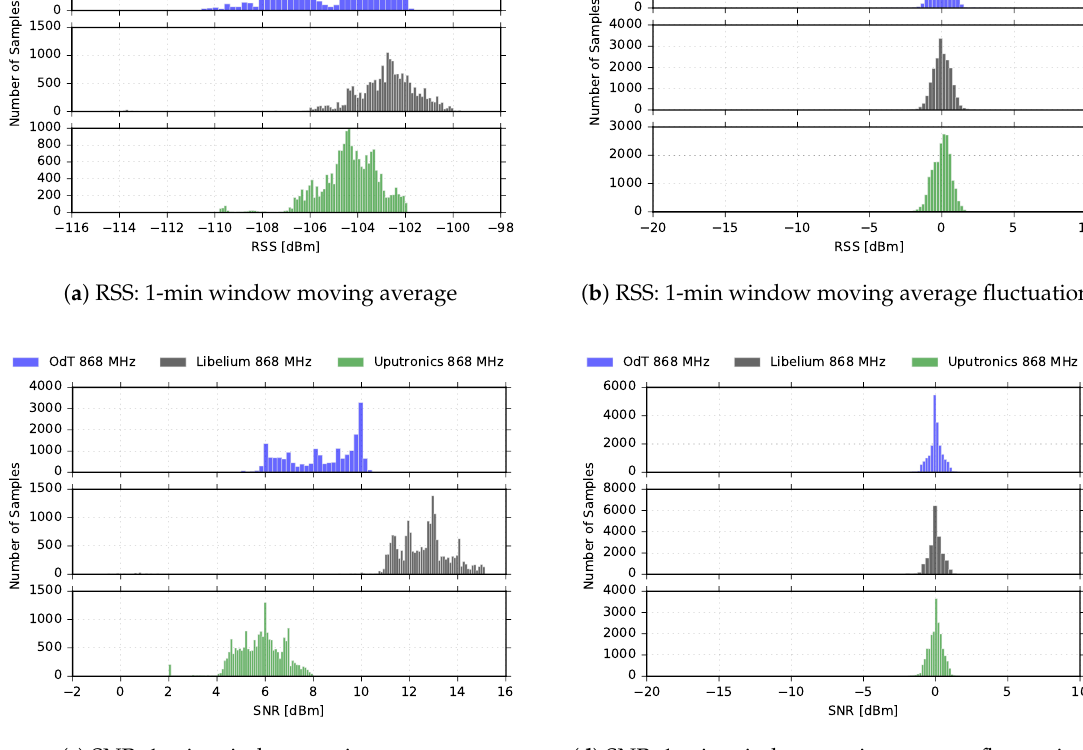
Figure 14. RSS and SNR histograms for ODT, Uputronics and Libelium: f = 868MHz, BW = 125kHz, SF = 12, CR = 4/6,